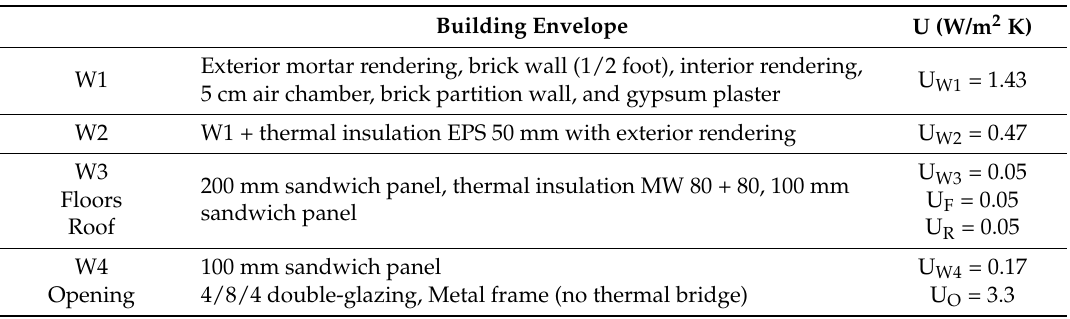
Table 1. Thermal envelope definition of the thermal transmittance (U-values).